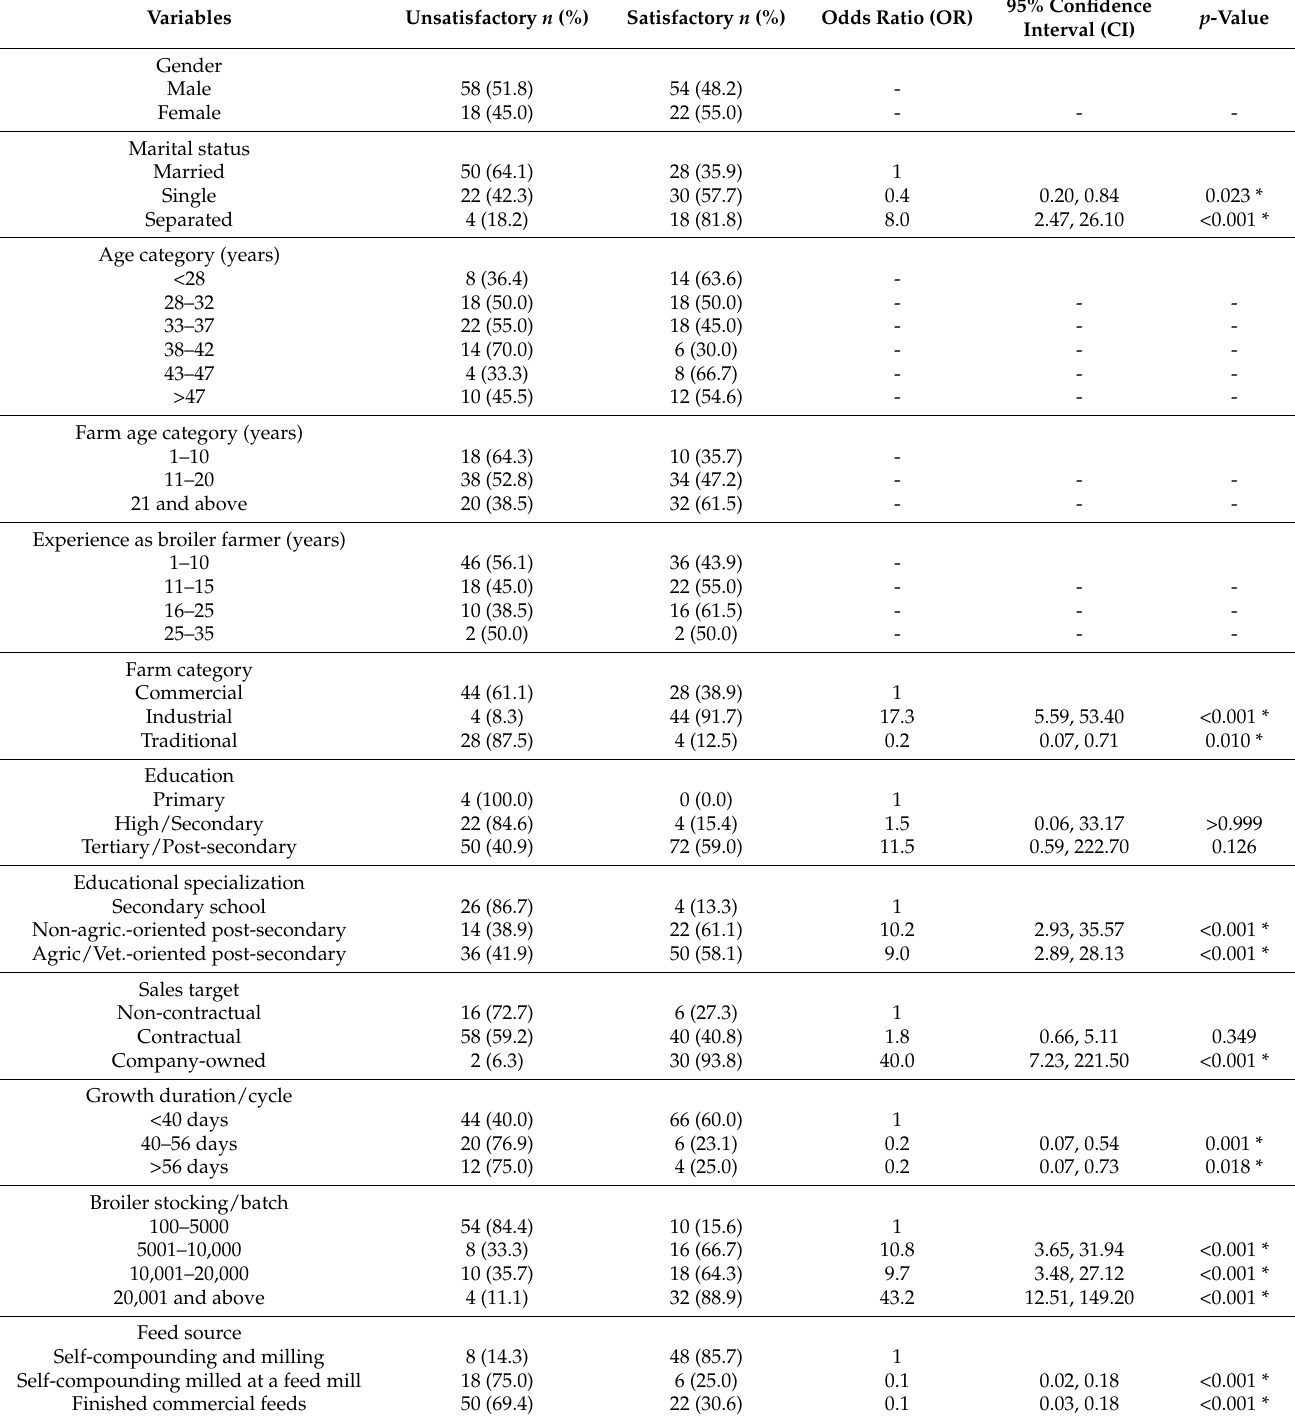
Table 7. Factors influencing knowledge levels of antimicrobial use and resistance among broiler grow-out farmers in Oyo State,